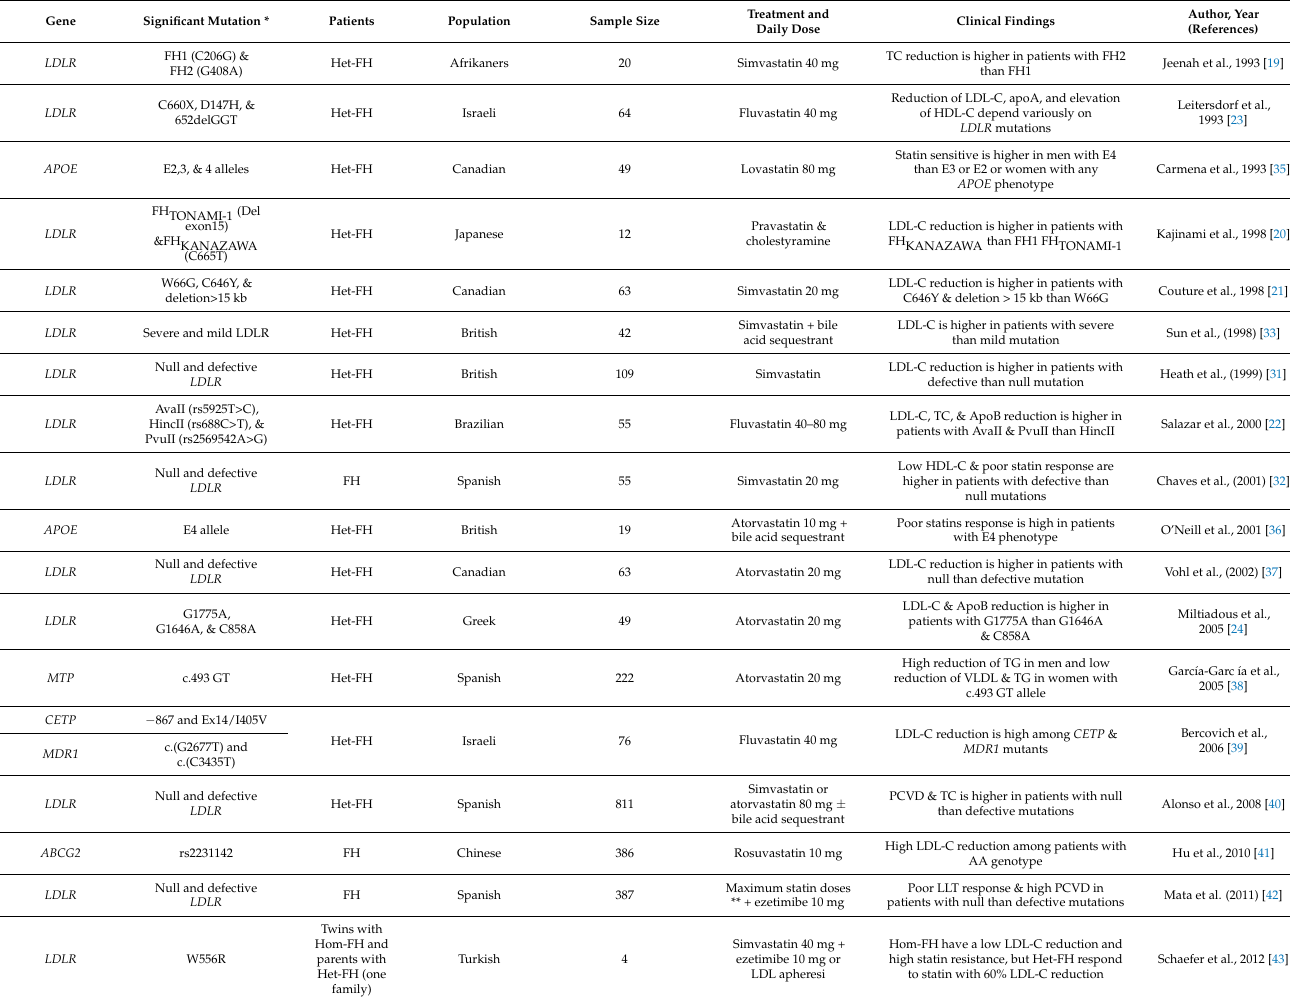
Table 1. Pharmacogenomics variations associated with statin response in familial hypercholesterolemia